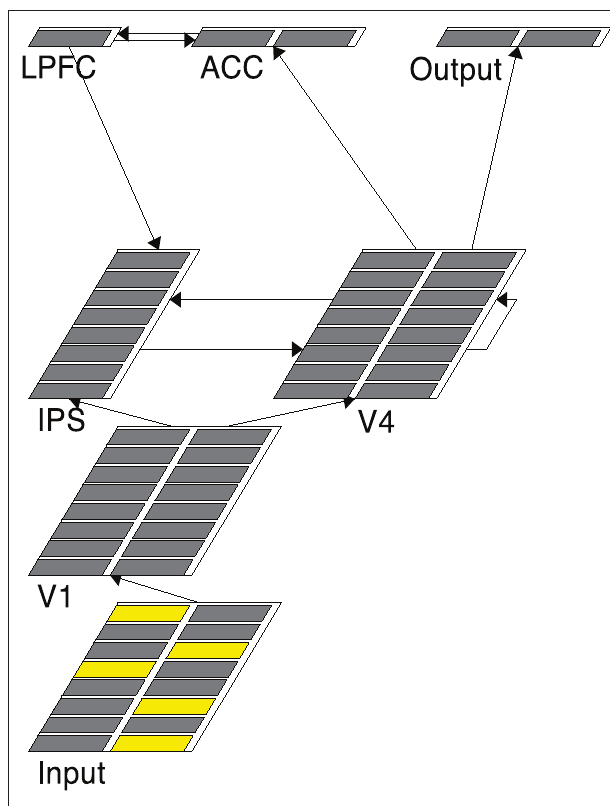
Figure 2 | A snapshot of the model structure. Each layer simulates a brain region designated by the layer name. The five active units (yellow) in Input represent the five arrow stimuli presented in a